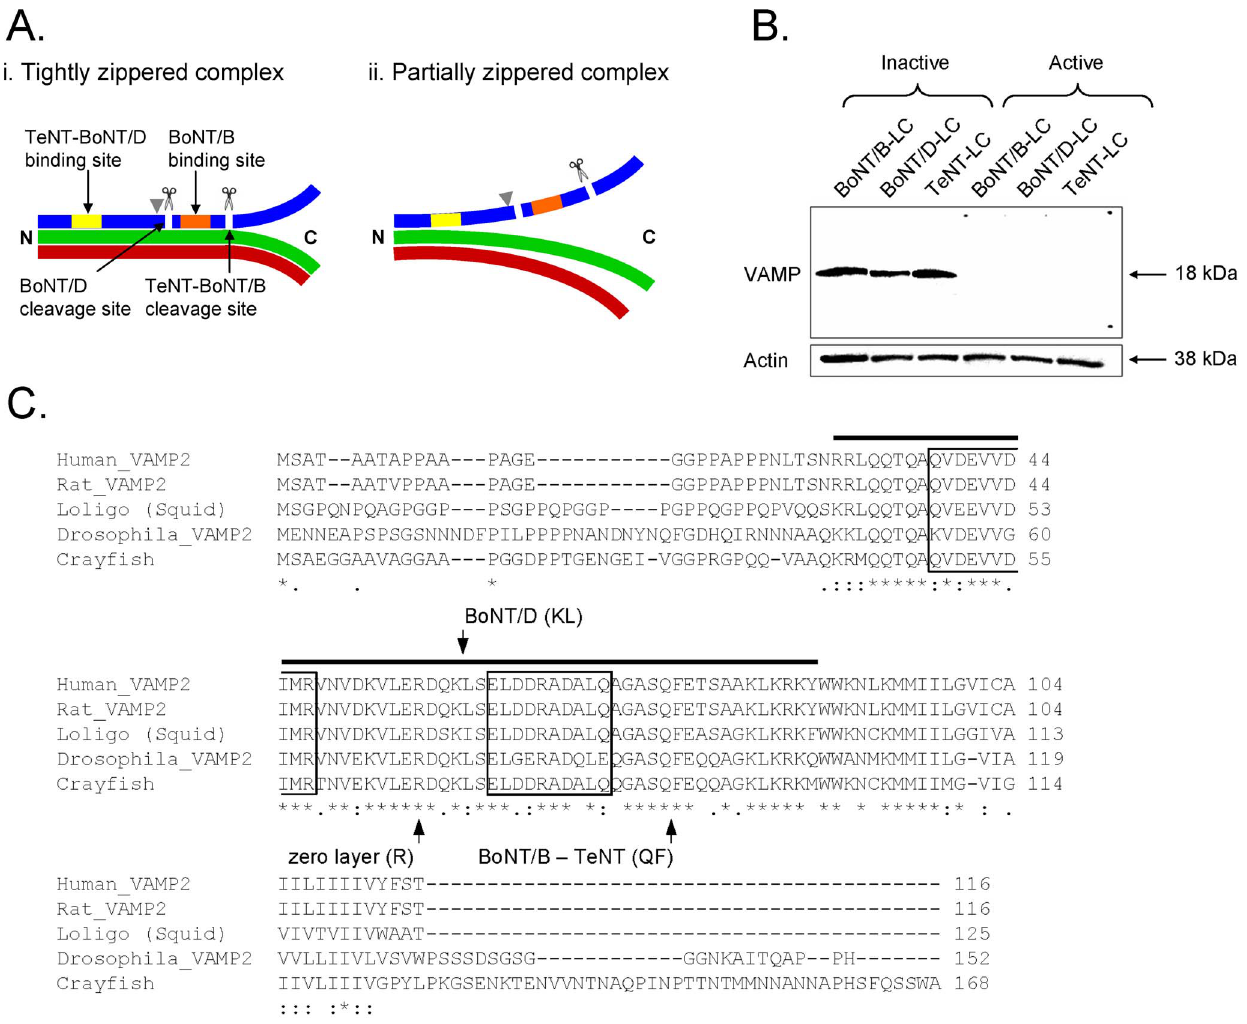
Figure 1. Susceptibility of VAMP to Clostridial neurotoxins. A , Zippered states of the SNARE complex. Ai , SNARE complex tightly zippered beyond the zero-layer indicated by gray arrow head. VAMP (blue) is protected from cleavage because the binding (yellow and orange bars) and cleavage (scissors and white lines) sites of VAMP-specific Clostridial neurotoxins (TeNT, BoNT/B and BoNT/D) are occluded. Aii , Partially zippered SNARE complex. The binding sites of TeNT and BoNT/D are occluded but the binding and cleavage sites for BoNT/B are exposed such that VAMP is susceptible to cleavage. Green – syntaxin, red – SNAP25 (represents both SNARE binding motifs). B , Clostridial neurotoxins cleave crayfish VAMP in- vitro . Crayfish CNS protein sample was incubated with inactive or active neurotoxins (BoNT/B-LC (0.5 m g/ m L), BoNT/D-LC (0.3 m g/ m L) and TeNT-LC (0.5 m g/ m L)) and stained for neuronal VAMP. The protein bands of 18 kDa represent VAMP. Cleaved VAMP does not appear on the blot when active neurotoxins were used because the VAMP antibody binds only to the uncleaved VAMP protein. Actin staining of 38 kDa below the VAMP blot shows that equal amounts (10 m g) of protein were loaded in each lane. C , Comparison of full-length crayfish VAMP amino acid sequence with VAMP sequences from other species. Crayfish VAMP is similar to VAMP from other species, especially in the conserved SNARE motif region (black bar). The cleavage sites of VAMP-specific neurotoxins are indicated in the alignment. The primary binding sites of the neurotoxins used in this study are indicated as boxed regions (V1 motif (aa 38–47) – TeNT and BoNT/D; V2 motif (aa 62–71) – BoNT/B) based on the human VAMP sequence [29–31]. The multiple protein sequence alignment was performed using the online ClustalW2 Multiple Sequence Alignment tool (European Molecular Biology Laboratory - European Bioinformatics Institute, http://www.ebi.ac.uk/Tools/msa/clustalw2/). doi:10.1371/journal.pone.0095130.g001 water was changed once a week and the crayfish were fed lentils. The first or second walking leg was removed from the cephalothorax (basipodite region) of the animal by autotomy. The leg was pinned down dorsal side up in a Sylgard-lined 35 mm Petri dish filled with a modified Van Harreveld crayfish saline solution [28] containing the following (in mM): 205.3 NaCl,